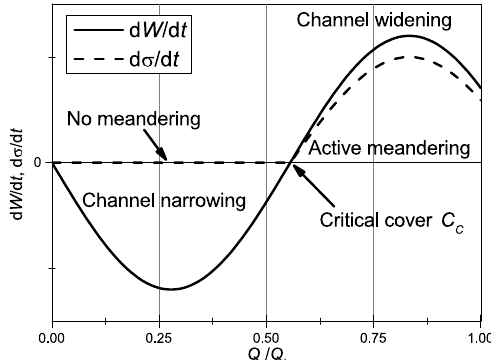
Figure 2. Schematic relation between the rate of change of width d W/ d t (black line) and sinuosity d σ/ d t (dashed line) with relative sediment supply Q s Q t . At low supply, no sediment particles impact the walls; the channel narrows and does not meander actively. At high supply, frequent sediment impacts on the channel walls drive lateral erosion, leading to channel widening and active meandering. At the critical cover, the rate of change of width is zero. The exact position of this point depends on absolute channel